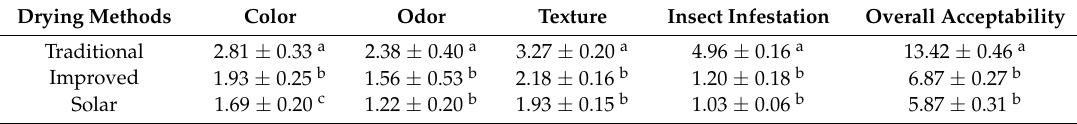
Table 4. Effect of the drying methods on the sensory properties of H. molitrix. Each value is expressed as a mean (1–10 scoring) ± SD ( n = 3). Means with different superscripts within a column are significantly different ( p <